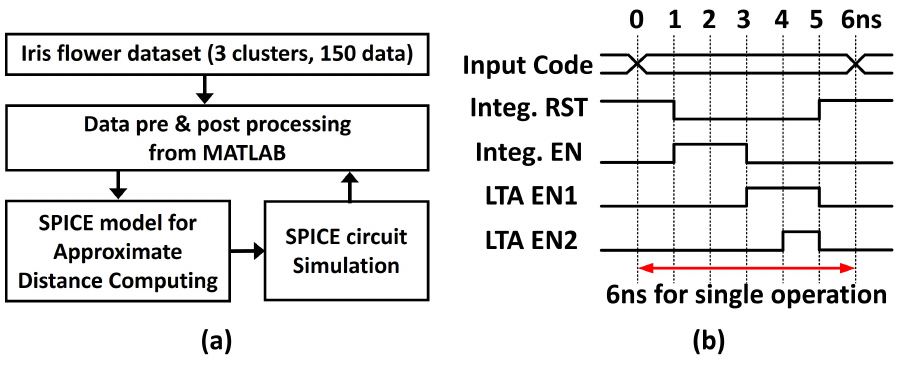
Figure 10. ( a ) Circuit-application co-simulation framework used for this work; ( b ) timing diagram for the proposed K-means clustering